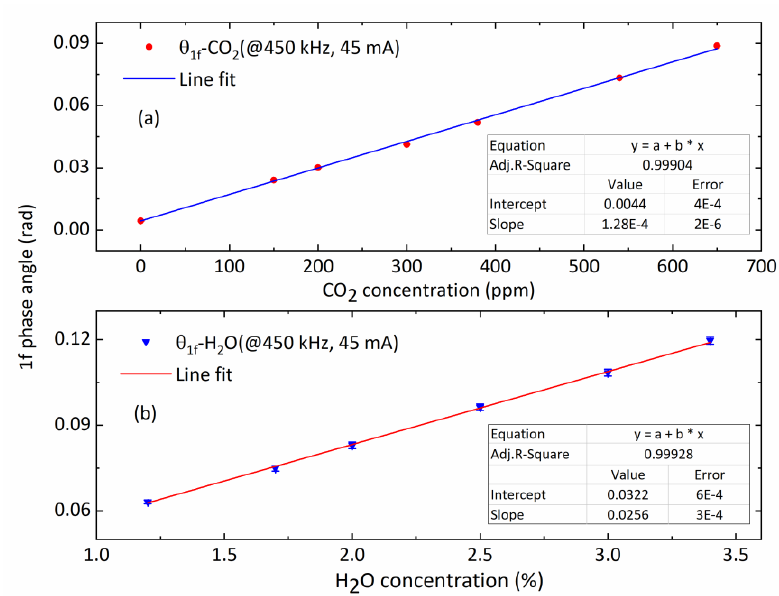
Figure 8. Calibration measurements of the peak-to-peak magnitude of the 1f phase angle θ 1 f at various reference gas concentrations of ( a ) CO 2 and ( b ) H 2 O vapor. Their good linear dependence is confirmed by the straight-line fit (solid line) with details shown in the